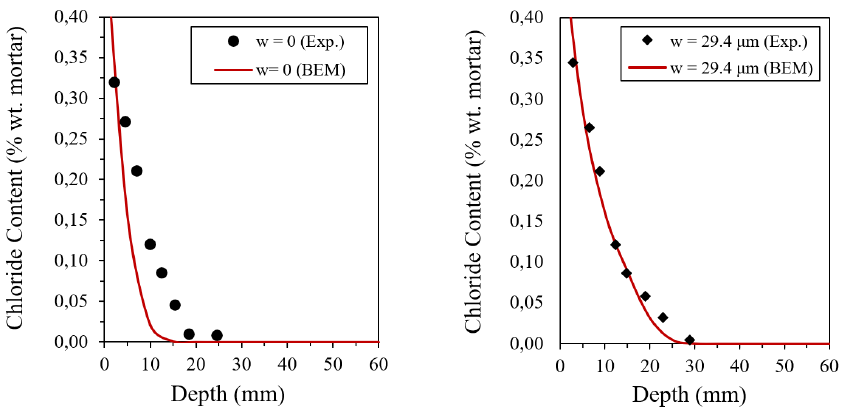
Figure 5. Comparison of results: Experimental (Exp.) [35] and numerical